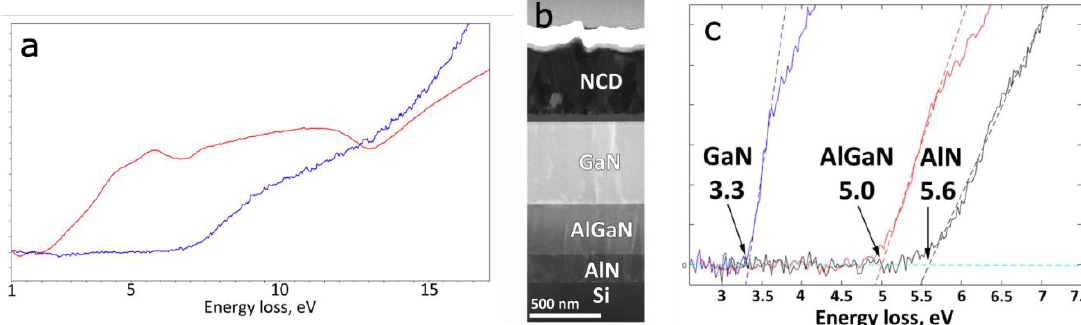
Figure 11. Improvement of band gap measurement. ( a ) Low loss spectrum acquired with the improved setup (blue) contrasted with one acquired in a conventional experiment (red). The distortion of the data caused by the parasitic losses is clearly visible; ( b ) ADF-STEM image of a multilayer sample composed of several wide-band gap semiconductors, and ( c ) recorded spectra clearly showing the onset of the inter-band transitions and, hence, the band gaps, for the different portions of the sample.